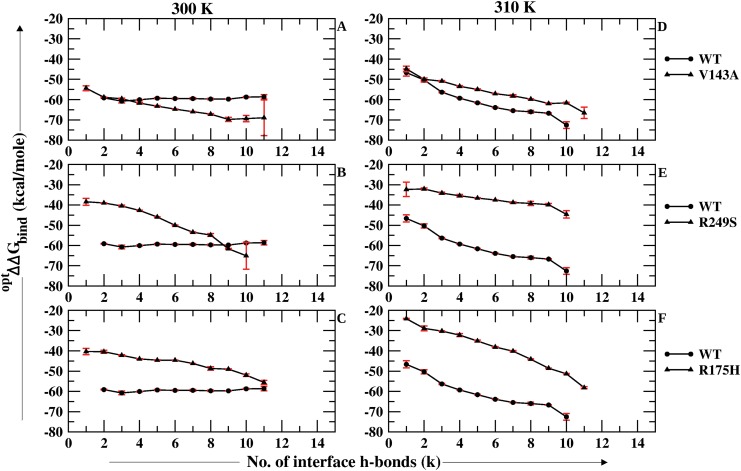
Comparison of optΔΔGbind for the p53 ts-mutants against wild type at both 300 K and 310 K.